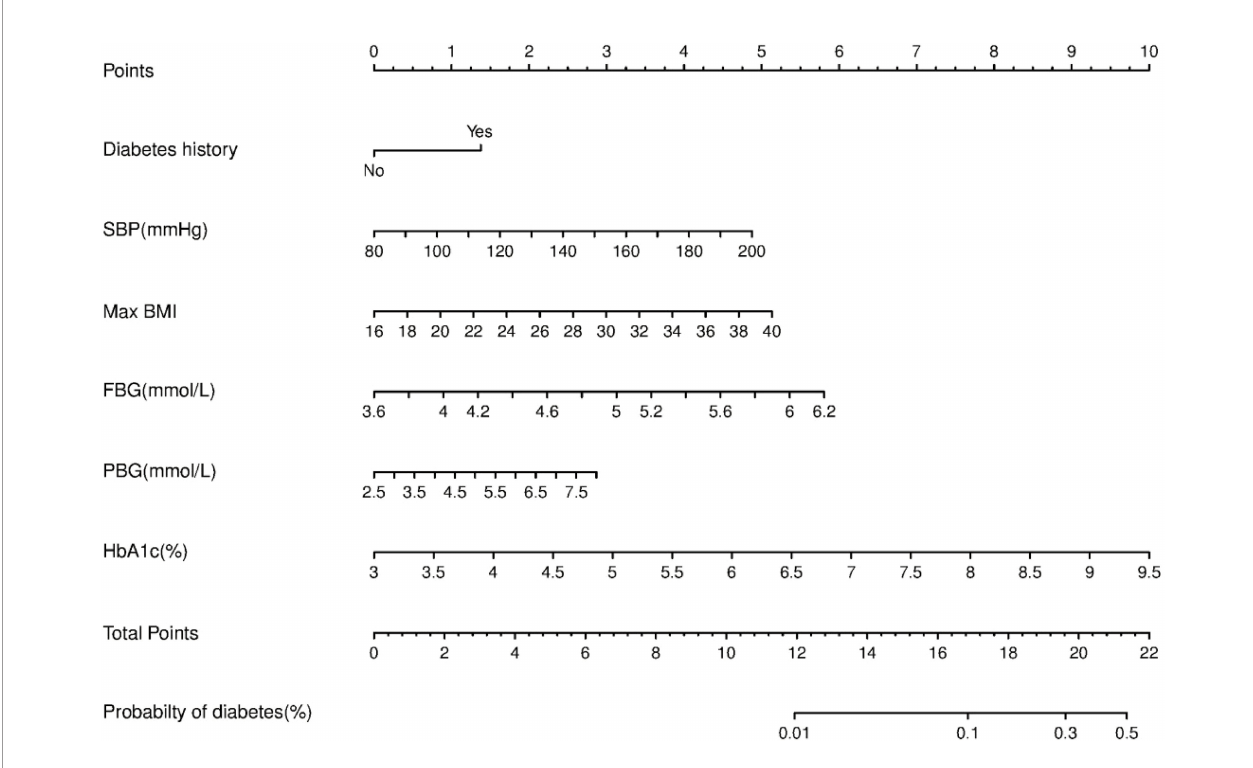
FIGURE 2 | Nomogram predictive model for diabetes in